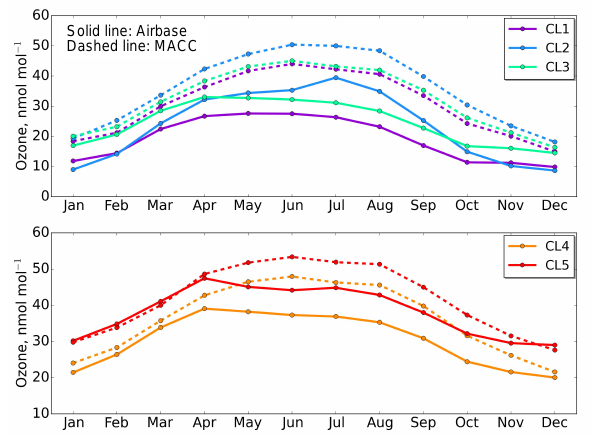
Figure 14. Diurnal cycles of cluster centroids; Airbase vs. MACC, first